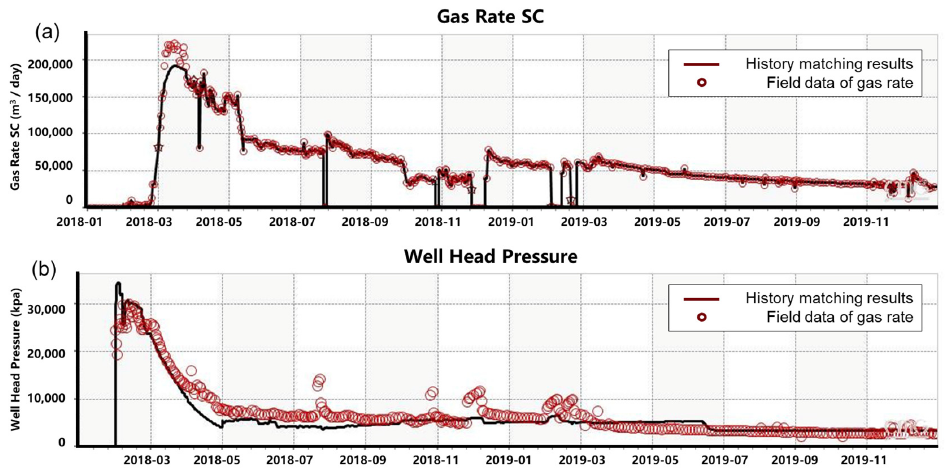
Figure 3. History matching results of ( a ) gas production and ( b ) wellhead pressure of Well #W2-B.